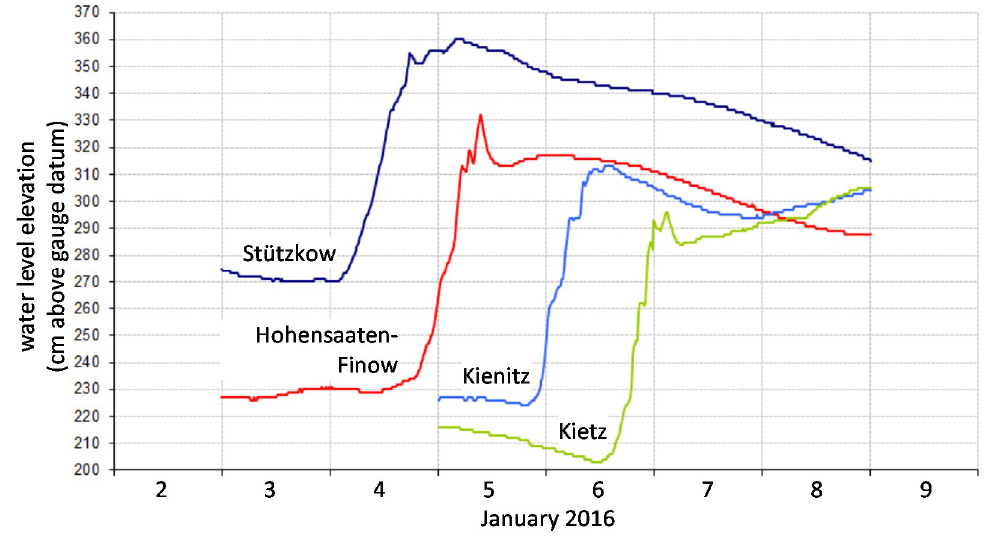
Figure 7. Backwater staging caused by an ice jam along the lower Oder River in January 2016. Water levels are shown for the gauges, in the downstream direction at Stützkow (Oder-km 685; values reduced by 300 cm in the graph), Hohensaaten-Finow (Oder-km 665), Kienitz (Oder-km 632) and Kietz (Oder-km 615) (data source: Wasser- und Schifffahrtsverwaltung, Eberswalde, Germany).